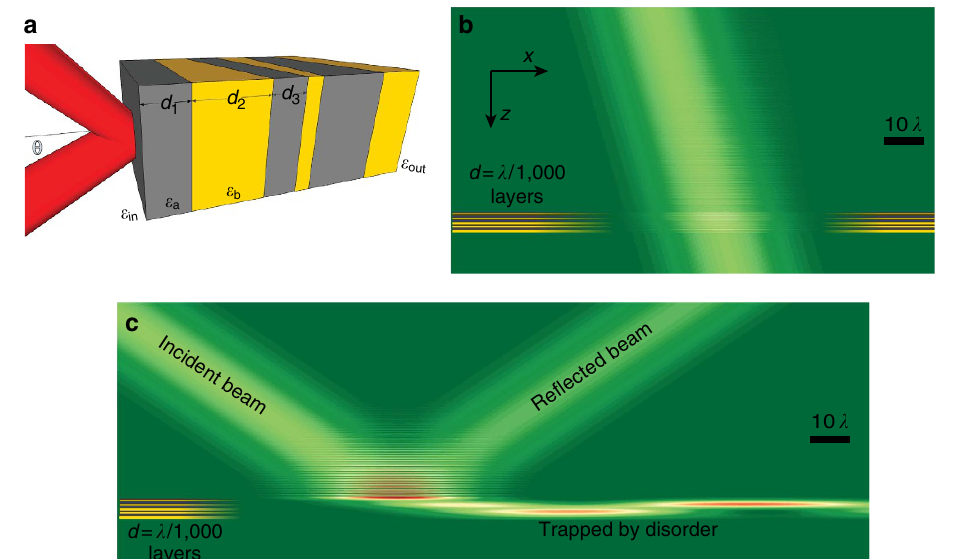
Figure 1 | Physical setting and simulated propagation of light in the multilayer stack with extremely deep subwavelength disorder. ( a ) Schematics of a disordered multilayer sample with N ¼ 3 pairs. ( b ) ATE-polarized 2D Gaussian beam incident at y ¼ 20 (cid:2) on a disordered stack of N ¼ 2,500 layer pairs. The beam goes through the structure unaffected by the disorder since the layers are 10nm thick on average—exceedingly thin relative to the l ¼ 10 m m wavelength of the beam—and since the incidence angle is far from the critical angle for total internal reflection. ( c ) The same beam and structure as in a , but for incidence at y ¼ 60 (cid:2) . For this angle of incidence, at the edge of the GHL regime, the beam is completely reflected by the presence of deep subwavelength disorder. Notably, a portion of the beam is coupled into a mode localized in the multilayer, and advances through the structure for a considerable distance. The yellow–grey stripes on the bottom-left hand side of b , c represent the location of the multilayer; the actual layers are 500 times thinner than in the